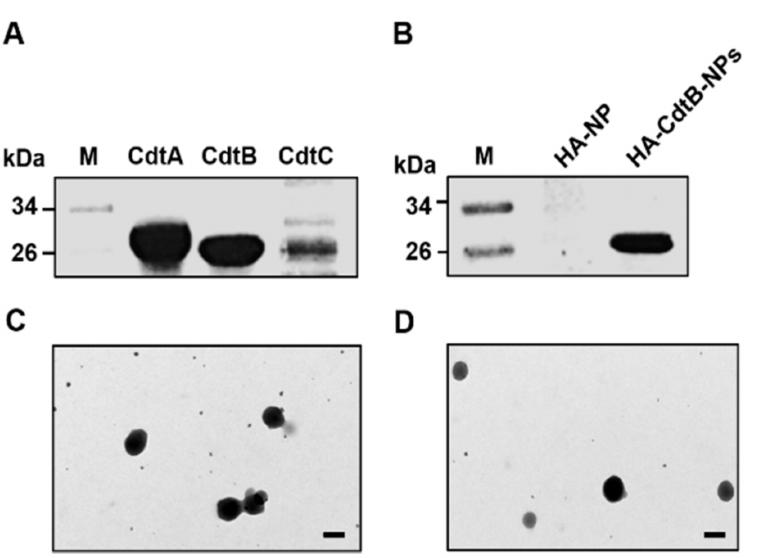
Figure 1. Characterization of HA-CdtB-NPs. SDS-PAGE analysis of ( A ) each recombinant CDT subunit and ( B ) HA-CdtB-NPs. Transmission electron micrographs of ( C ) HA-NPs and ( D ) HA-CdtB- NPs. Scale, 200